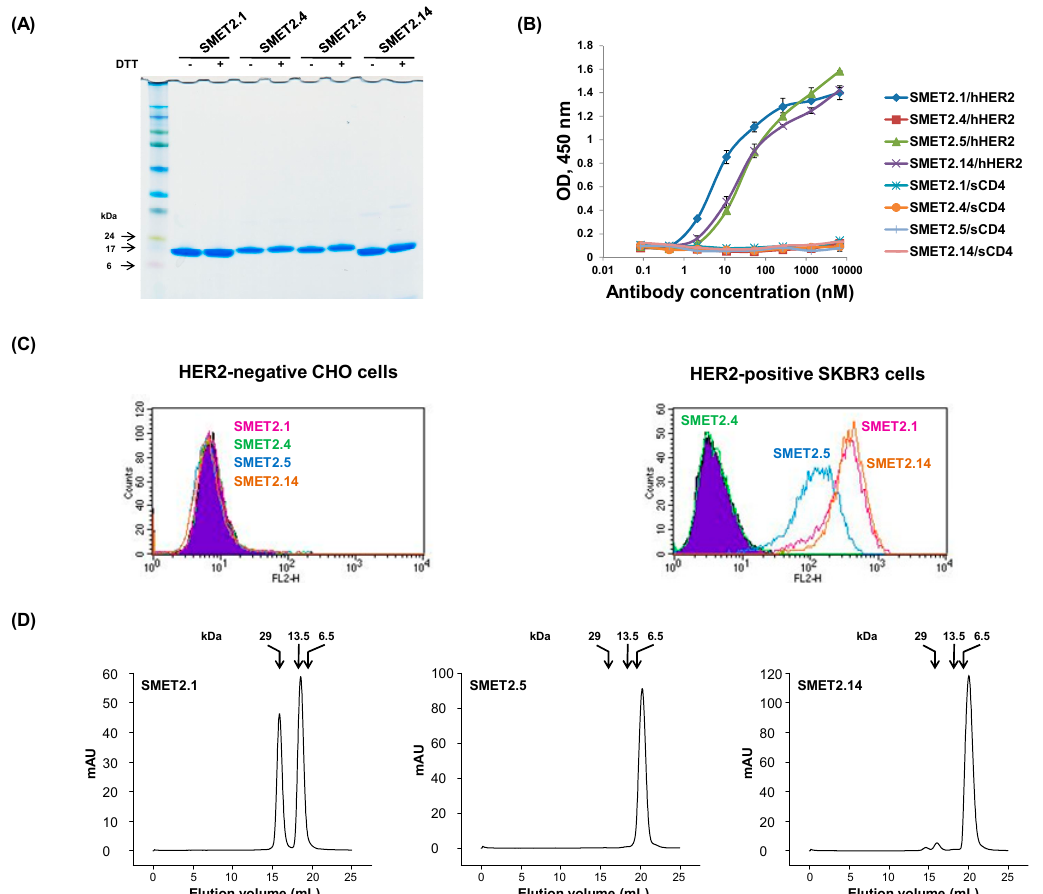
Figure 1. Identification and initial characterization of anti-HER2 dAbs. ( A ) Non-reducing and reducing SDS-PAGE of selected anti-HER2 dAbs. Molecular masses of standards are shown on the left. ( B ) ELISA binding of the anti-HER2 dAbs to hHER2 and sCD4, an irrelevant antigen. Antigens were coated on 96-well plates at a concentration of 2 µ g mL − 1 . Bound dAbs were detected by horseradish peroxidase (HRP)-conjugated anti-FLAG tag antibody. The assay was performed in duplicate. Results are the mean ± standard deviation. ( C ) Flow cytometry analysis of the dAbs. Diagrams for reference cells are filled with purple. Diagrams for cells incubated with SMET2.1, SMET2.4, SMET2.5, and SMET2.14 are in pink, green, blue, and yellow, respectively. ( D ) Size-exclusion chromatography of the dAbs. The arrows at the top indicate the elution volumes of molecular mass standards in PBS (pH 7.4).